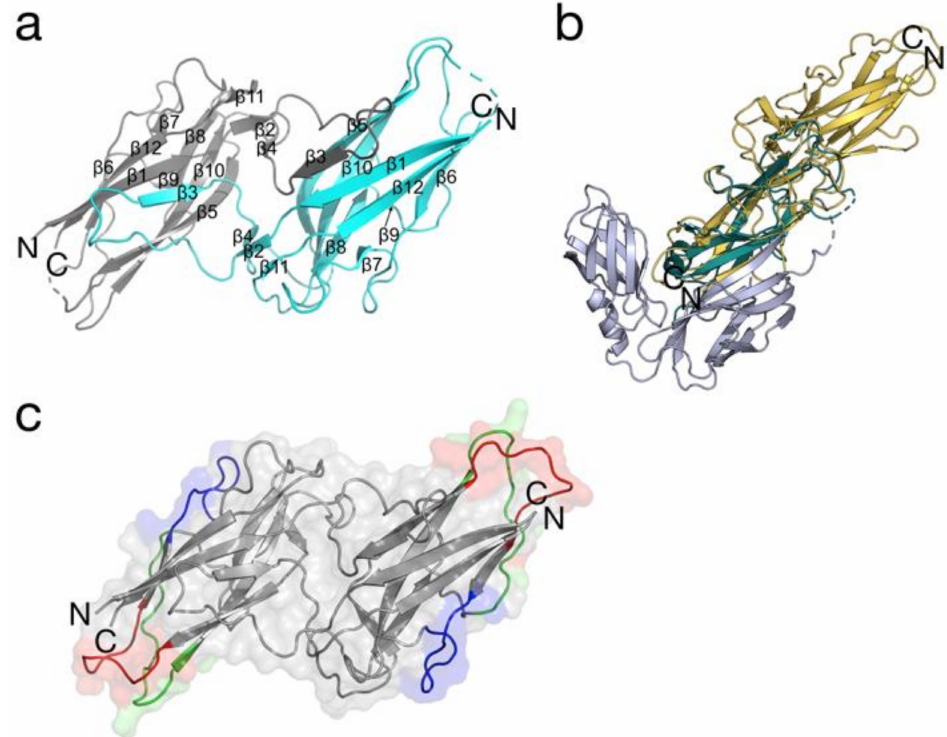
Figure 1. The crystal structure of BPSL1626. ( a ) Cartoon representation of the secondary structure organization chains A (grey) and B (turquoise) that comprise the BPSL1626 dimer. β -strands are numbered and the C- and N-termini of each chain are indicated. Gaps in the structure are indicated by dashed lines. ( b ) Structural superimposition of the BPSL1626 (gold ribbons) chain A with chain D of N-terminally truncated FimA (green ribbons) from E. coli strain K12 (PDB entry 4DWH). Two FimC chains are also shown (grey ribbons). ( c ) Location of computationally-predicted epitopes on the crystallographic BPSL1626 dimer. The three predicted epitope are highlighted in: red (epitope 81-LKNCGASTSGAT-92), blue (epitope 96-MGTTDSANPAA-106), and green (132-GSSSKAYTIAEGDNT-146) on each monomer. Surfaces are shown for the dimer, with appropriate shading for the epitope regions. ( a ) was generated using Pymol version 1.8. ( b , c ) were generated using Pymol